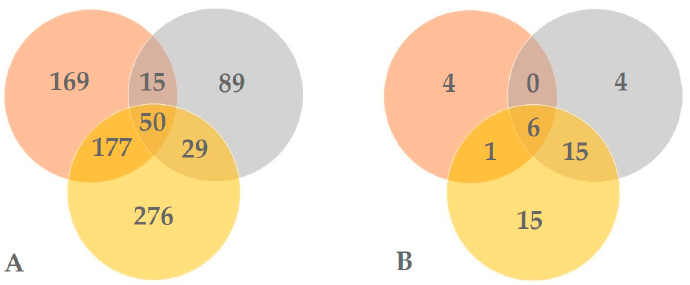
Figure 4. Venn diagram showing the diversity and overlap of fungal taxa in spore trap samples from the three sampling sites: ( A )—all fungal taxa; ( B )—plant pathogenic fungal taxa. Different colors represent different sites: Grey—Dubrava, Orange–Labanoras, Pink—Lenkimai (Numbers indicate the amount of unique and overlapping taxa in the study sites).